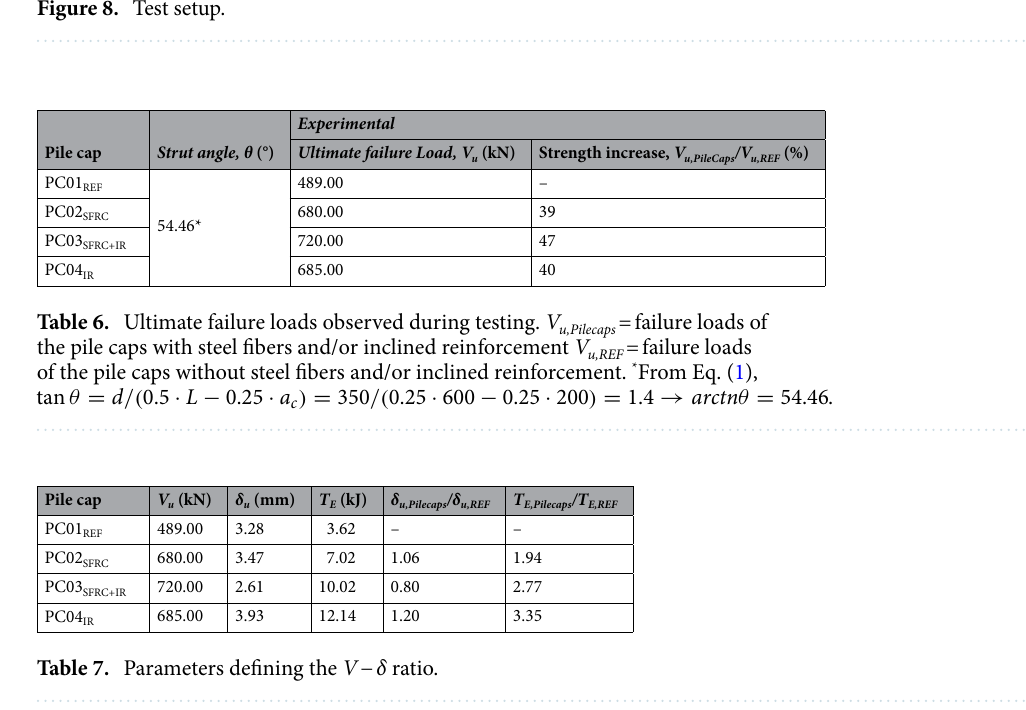
Figure 8. Test setup.